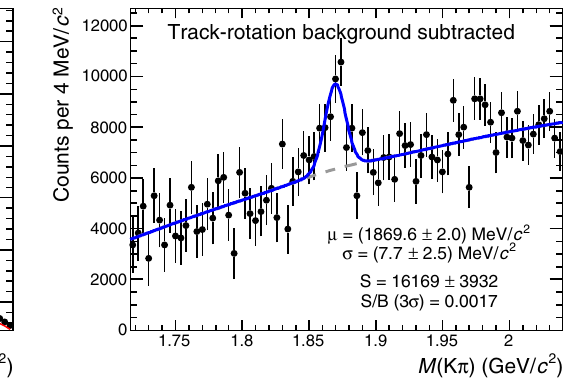
Fig. 3 Invariant-mass distributions of D 0 → K − π + candidates (and chargeconjugates)for0 < p T < 0 . 5GeV / c .Theleftpaneldisplaysthe invariant-massdistributionofallopposite-signK π pairs(orunlikesign, ULS in the legend) together with the background distribution estimated with the track-rotation technique. The right panel shows the invariant-